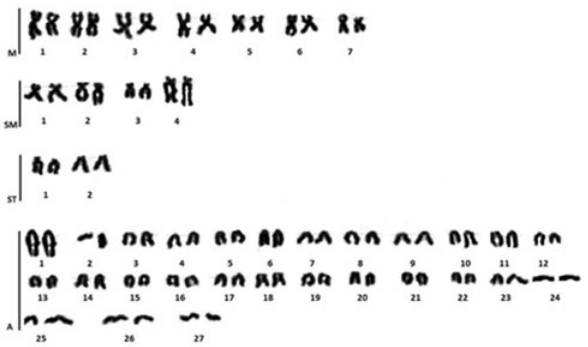
Figure 1. Karyotype of Abant trout Salmo t. abanticus (2N=80) stained conventionally with Giemsa . Metacentric (M), submetacen- tric (SM), subtelocentric (ST), acrocentric and telocentric chromo- some (A/T) of